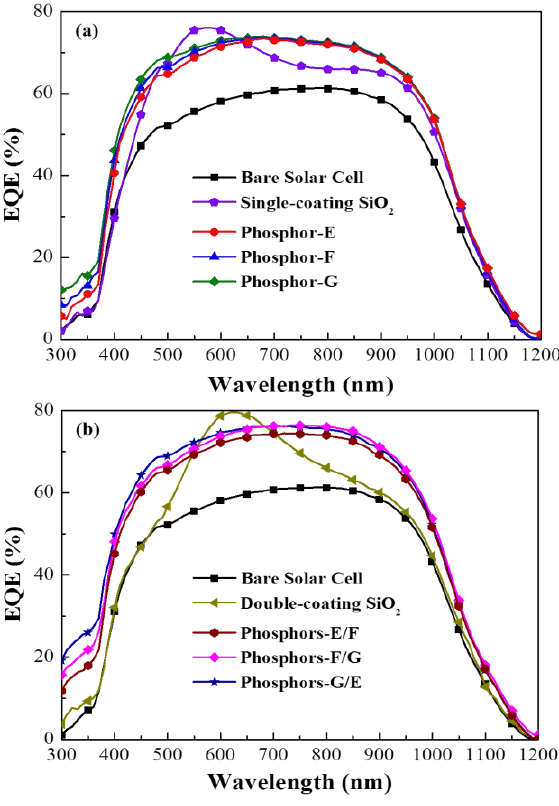
Figure 8. EQE spectra of proposed silicon solar cells: ( a ) single coating; ( b ) double coating.